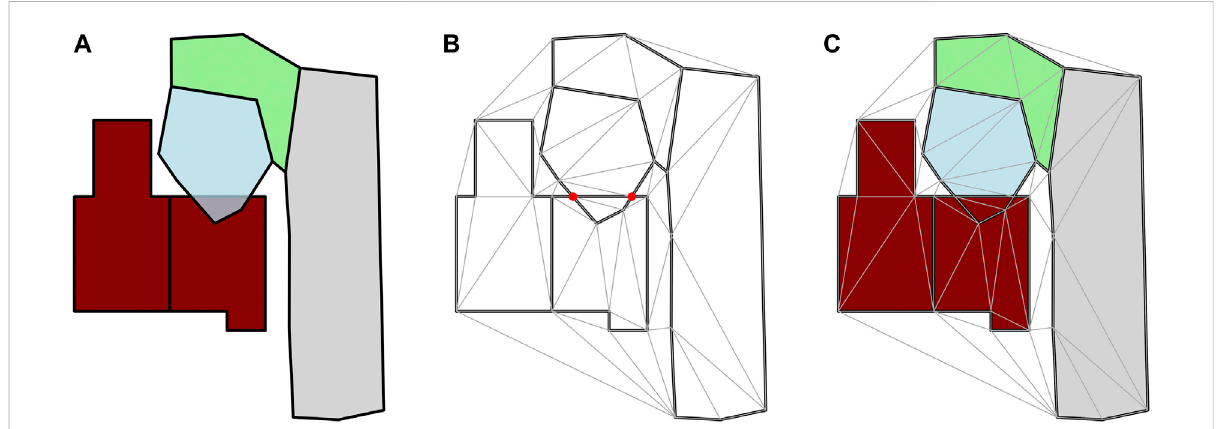
FIGURE 4 (A) 5polygons:2buildings,1pond,1grass fi eld,and1road. (B) ResultingCDT.Observethat2polygonsareoverlapping(pondandonebuilding), their edges were split at the intersections and new vertices added (in red). (C) Triangulation with labels from the input polygons (with overlap fi